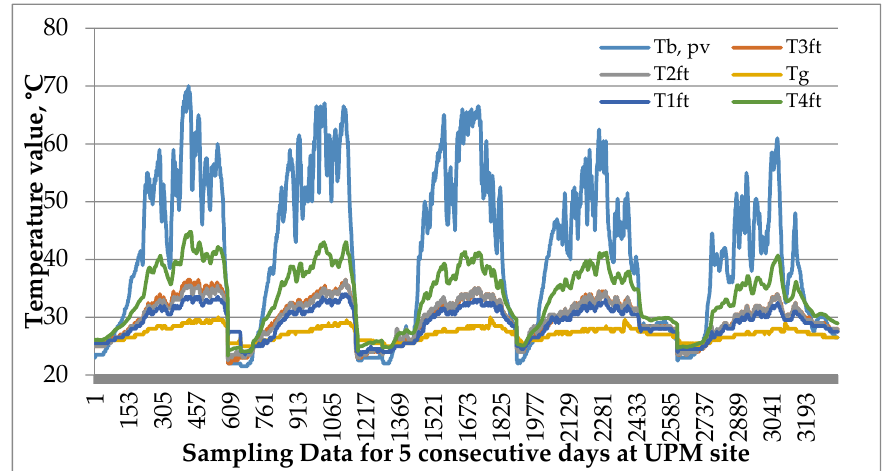
Figure 7. Temperature trends under agrivoltaic conditions at 1 min intervals (12 h daily). Abbreviations: T g : Ground temperature; T 1ft,2ft,3ft,4ft : Temperature at 1 foot intervals; T b, pv : PV panel’s bottom surface temperature.